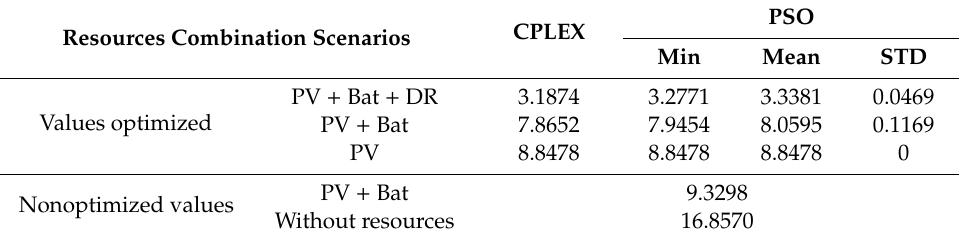
Table 4. Results for Equation (2) ( € /